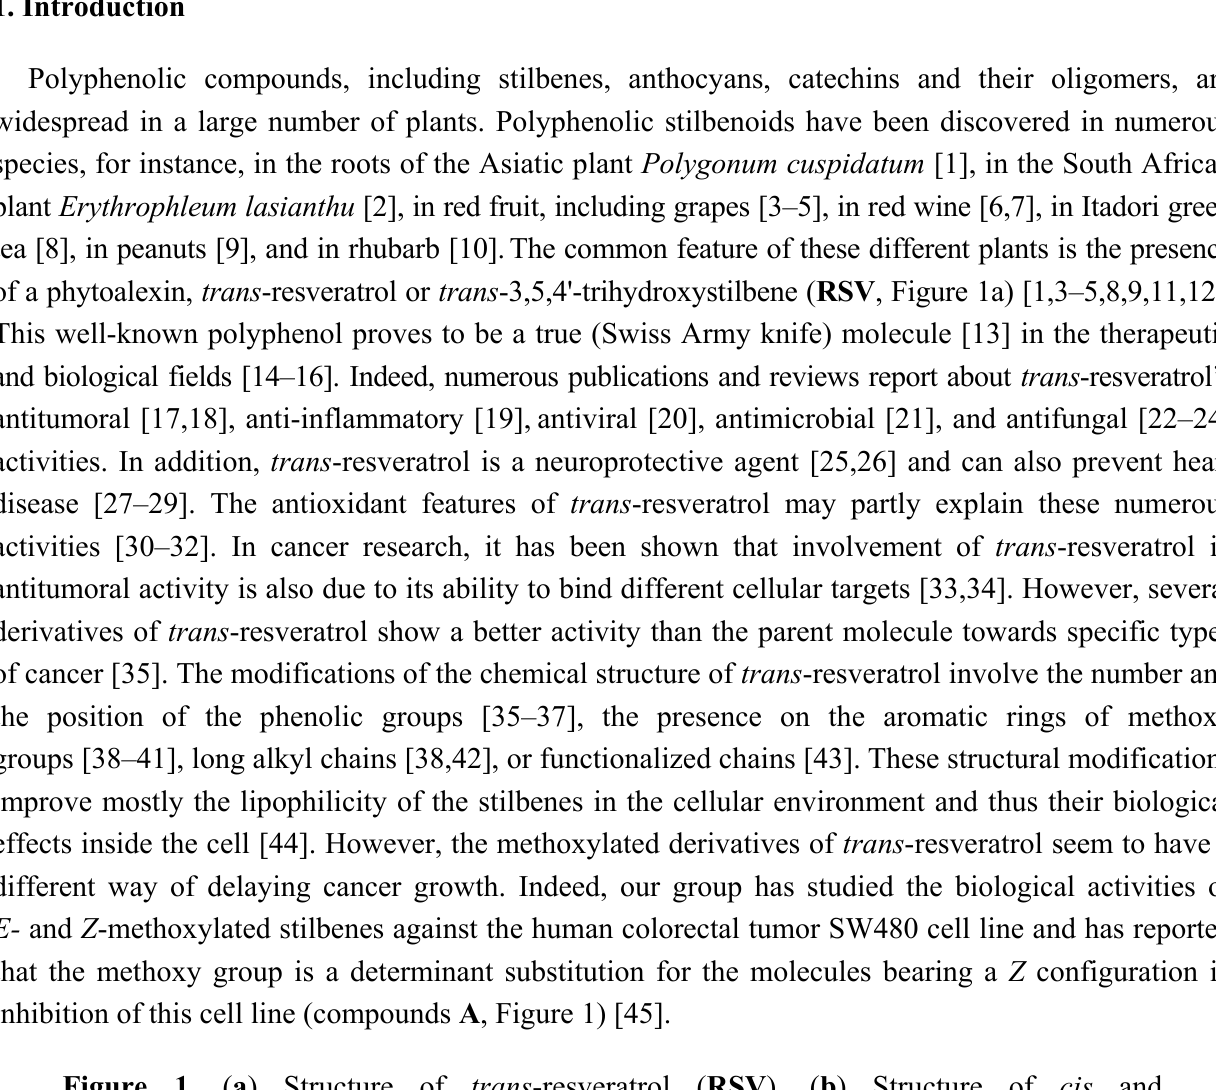
Figure 1. ( a ) Structure of trans -resveratrol ( RSV ). ( b ) Structure of cis and trans -resveratrol